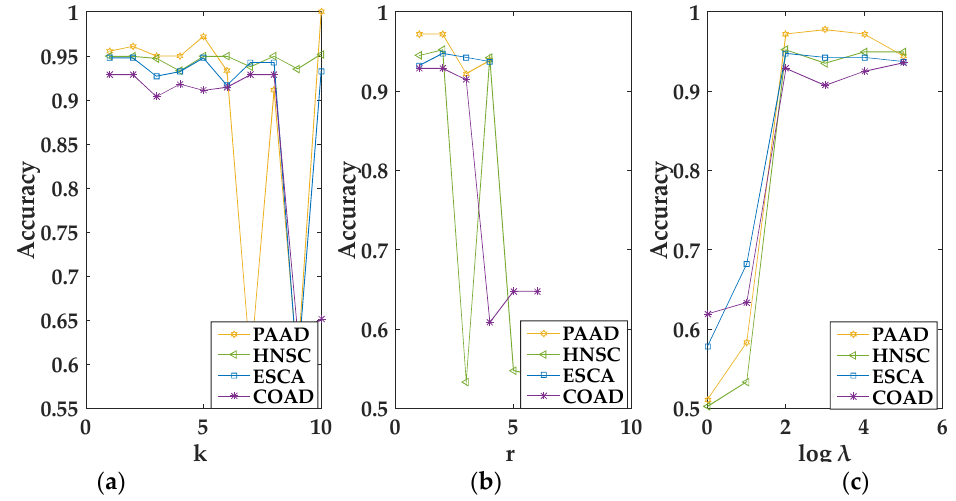
Figure 2. Performance of the graph regularized MvNMF (GMvNMF) set with different values of k , r and λ . ( a ) is the clustering performance of GMvNMF on PAAD, HNSC, ESCA and COAD about k ; ( b ) is the clustering performance of GMvNMF on PAAD, HNSC, ESCA and COAD about r ; ( c ) is the clustering performance of GMvNMF on PAAD, HNSC, ESCA and COAD about λ